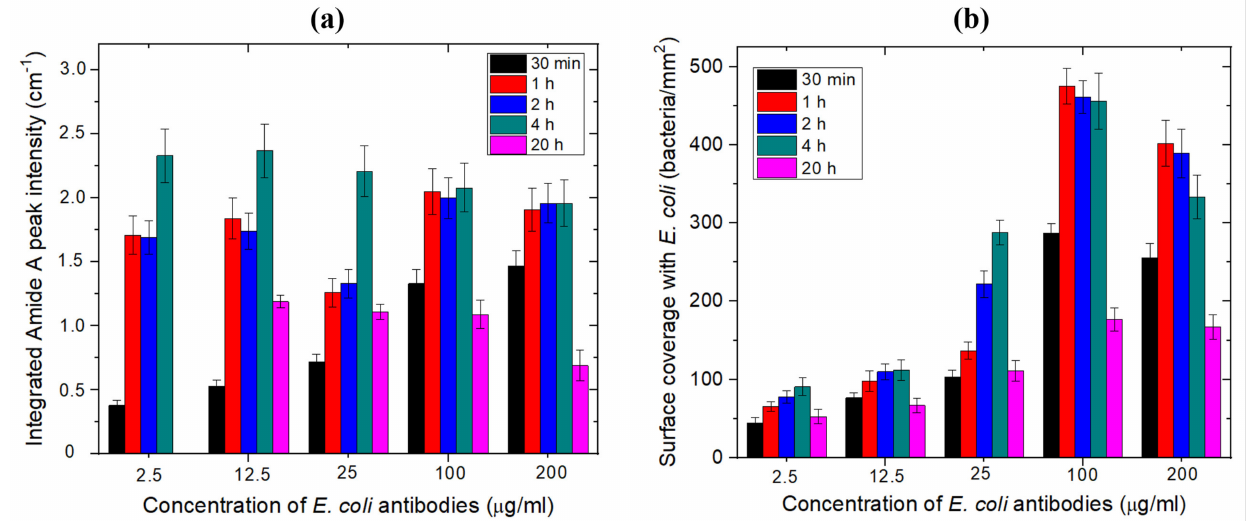
Figure 4. ( a ) Integrated FTIR amide A peak intensities for different incubation times and concentrations of E. coli antibodies prepared in PBS buffer (pH 7.4) on MHDA/MUDO (1:9) functionalized samples. ( b ) Surface coverage with E. coli bacteria immunocaptured on the biofunctionalized surface, determined by fluorescence microscopy for different concentrations and incubation times of E. coli antibodies ( n = 3 samples per concentration and incubation